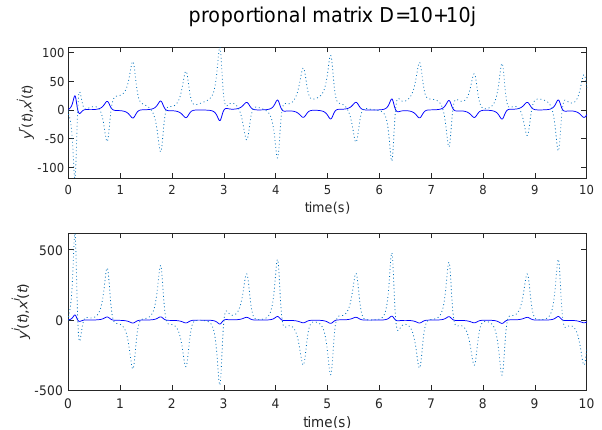
Figure 4. The diagram of state variables x 1 and y 1 without noise.